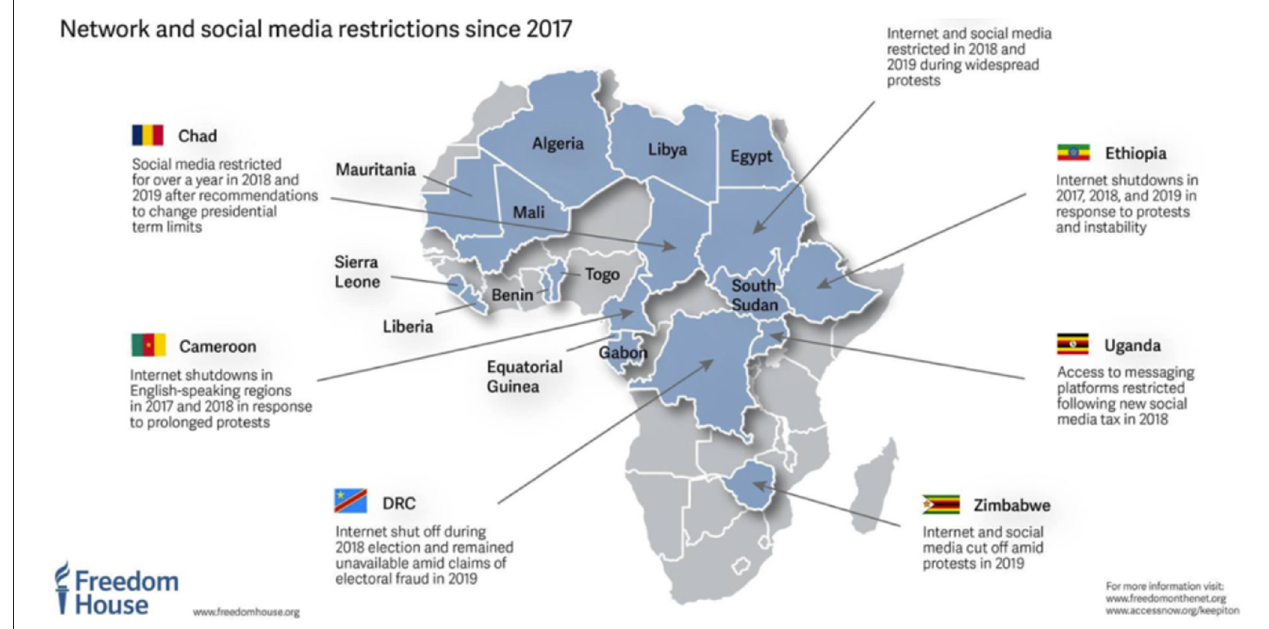
FIGURE 3 | Internet restrictions within Africa between 2017 and 2019 from Freedom House data Available online at: https://twitter.com/freedomhouse/status/ 1138135355931201536/photo/1 (accessed April 4, 2021).